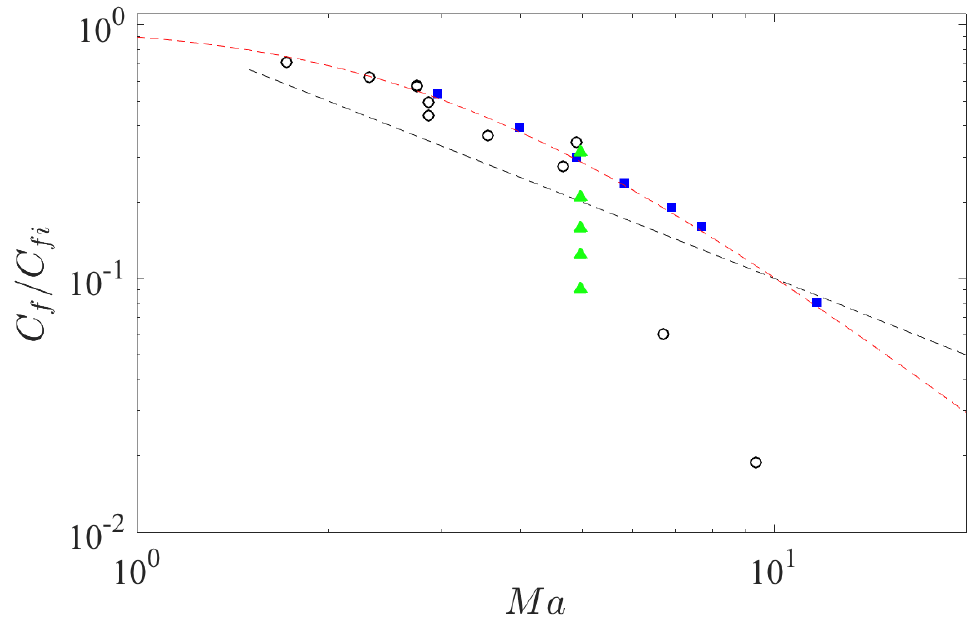
Figure 2. The effect of Mach number on skin friction.